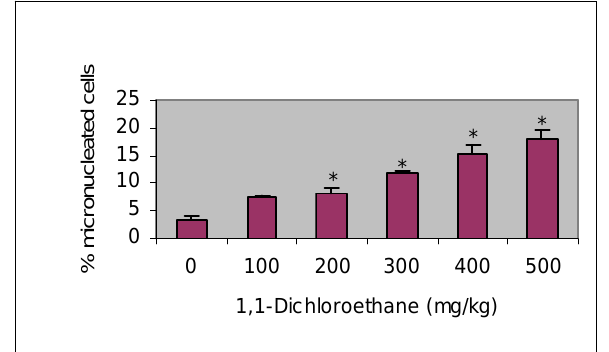
Figure 3: Effect of 1,1-Dichloroethane on the percent Micronuclei